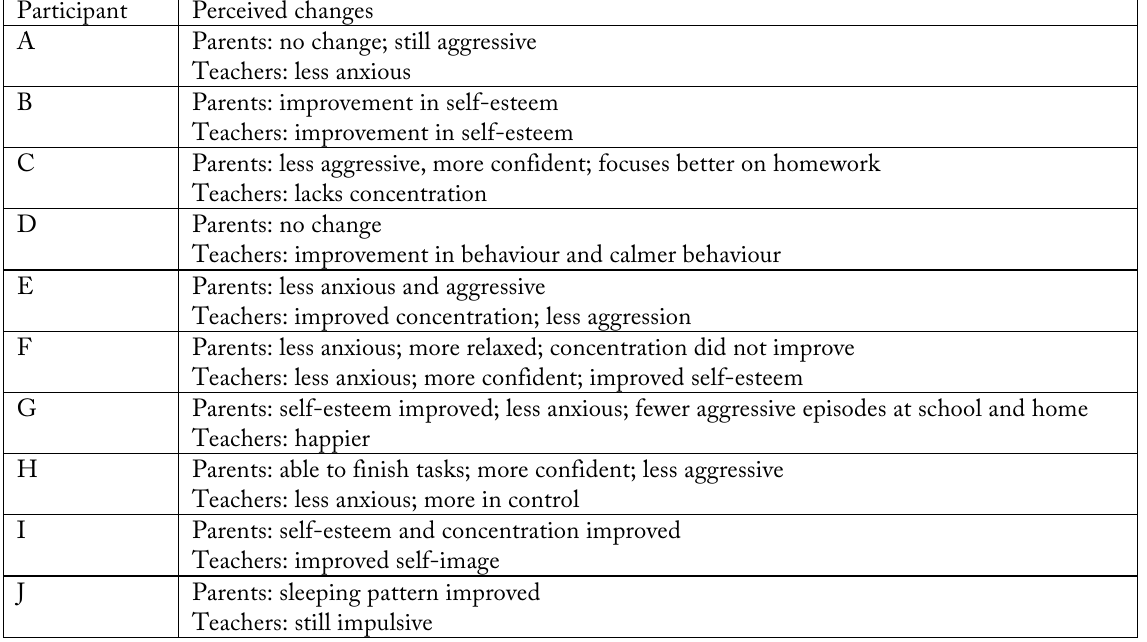
Table 3. The perceptions of parents and teachers of the influence of yoga on learners